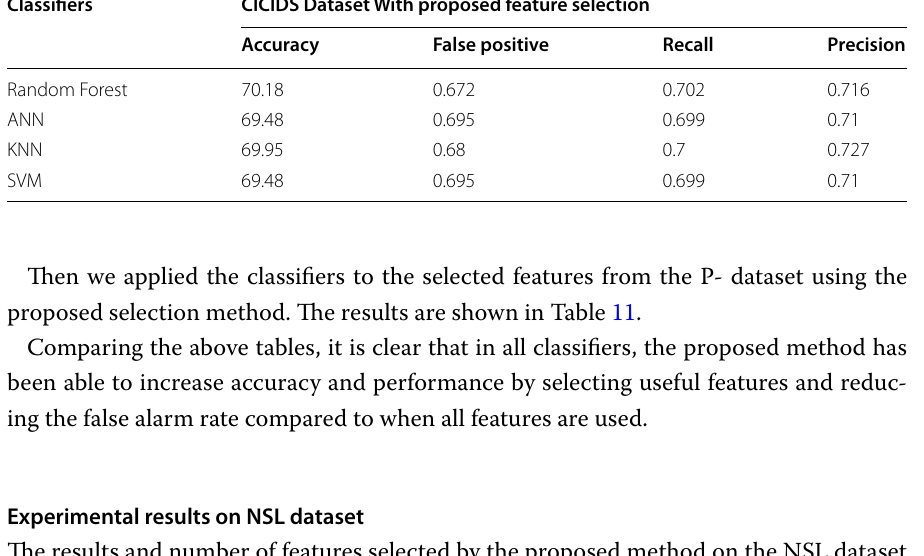
Table 18 Results on CICIDS with proposed feature selection